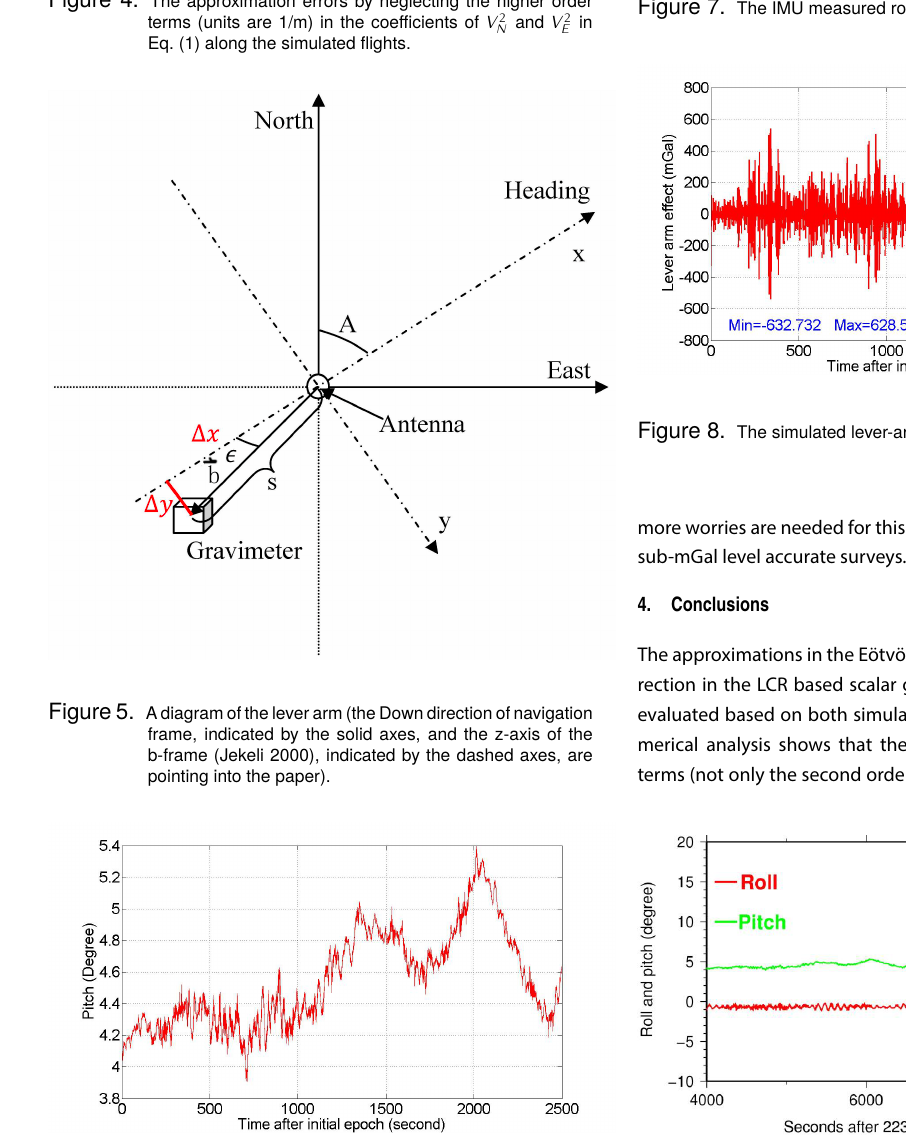
Figure 7. The IMU measured roll angles along a typical flight.